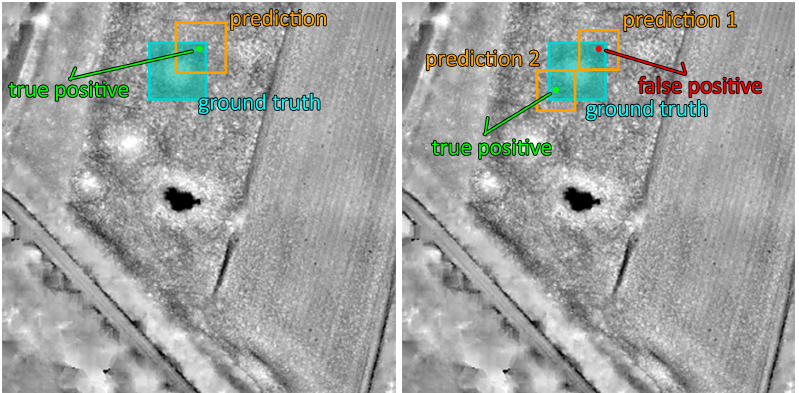
Figure 5. The centroid-based measure provides a quantitative evaluation of the spatial relationship between predicted and ground truth objects. ( Left ) A prediction is considered as a TP ( (cid:110) ) if the predicted ( (cid:110) ) object’s centroid falls inside the area of (at least) one ground truth’s bounding box ( (cid:110) ). ( Right ) If there are two or more distinct predictions whose centroids fall inside the same ground truth’s bounding box, only one is considered as a TP ( (cid:110) ), while the others are considered as FPs ( (cid:110) ). The centroid-based measure gives more importance to the location (i.e., the central